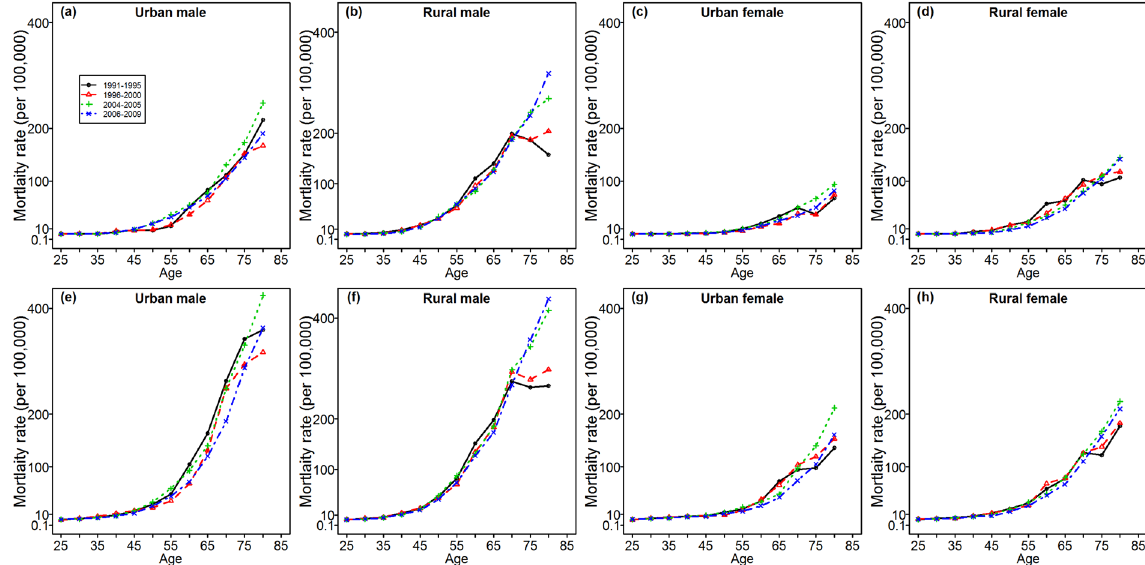
Figure 1. Age-specific mortality rates of esophageal and gastric cancers by period of death, stratified by region and sex during the period of 1991–2009. ( a–d ) In the first row represent esophageal cancer mortality; ( e–h ) In the second row represent gastric cancer